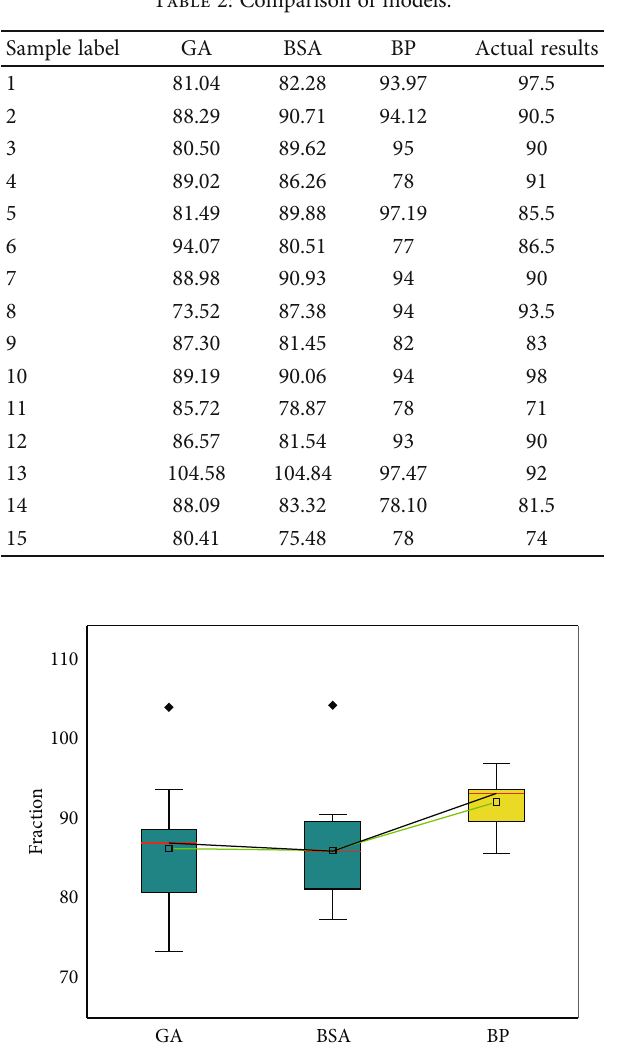
Figure 6: The box diagram of evaluation